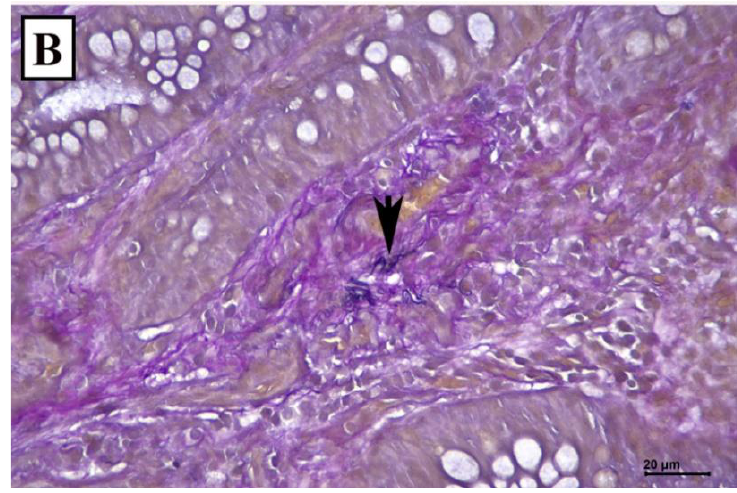
Figure 3. Weigert Van Gieson stain demonstrates elastic fibres in the lamina propria (arrow) ( A ): scale bar 100 µm, ( B ): scale bar 20 µm).